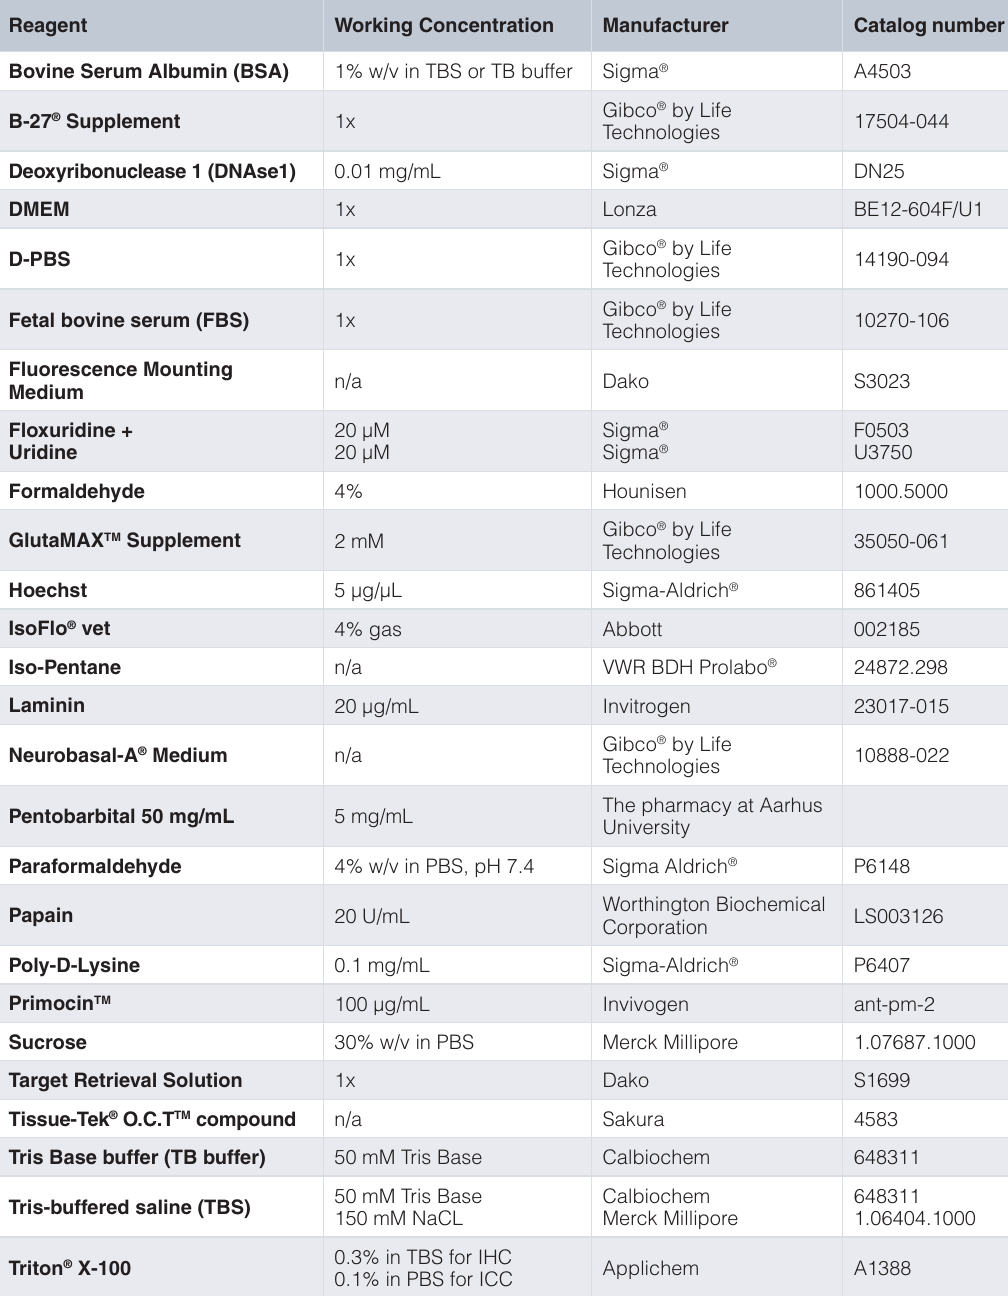
Reagent Working